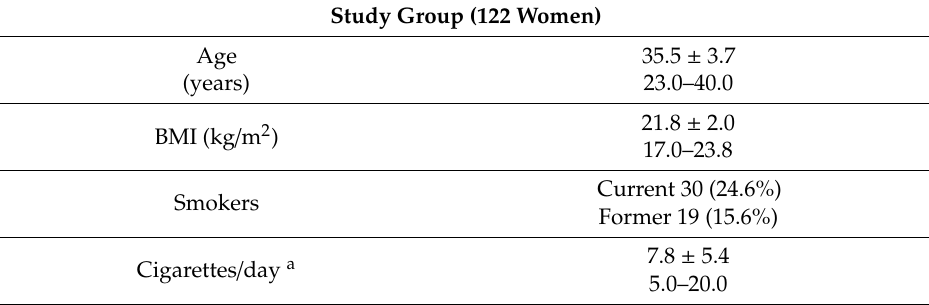
Table 2. Patients demographics. Continuous data are described as means ± standard deviations and range (in